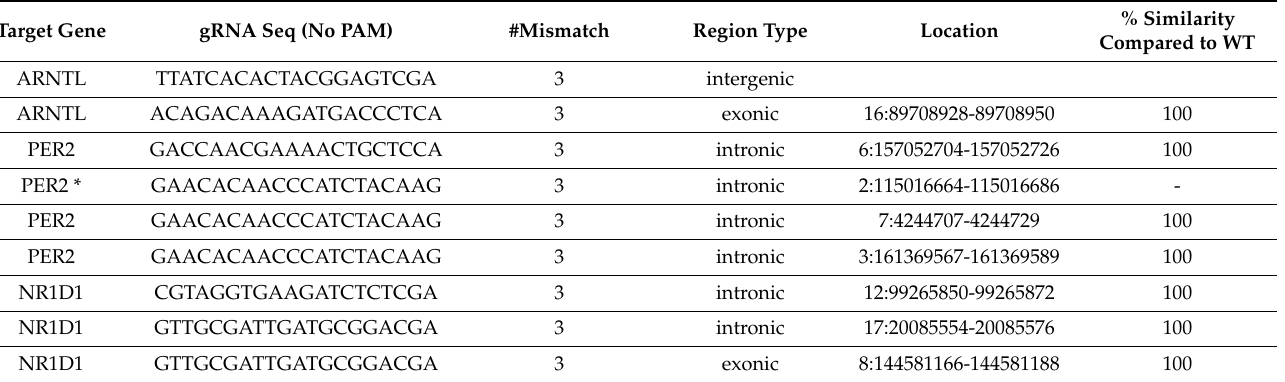
Table 2. List of potential predicted off-target regions using gRNAs targeting ARNTL , PER2 or NR1D1 with up to three mismatches within a protein-coding gene compared with the target region. PCR amplified products were Sanger-sequenced and compared with WT. * Primer also binds to other genomic regions (band sizes comparable to WT on gel